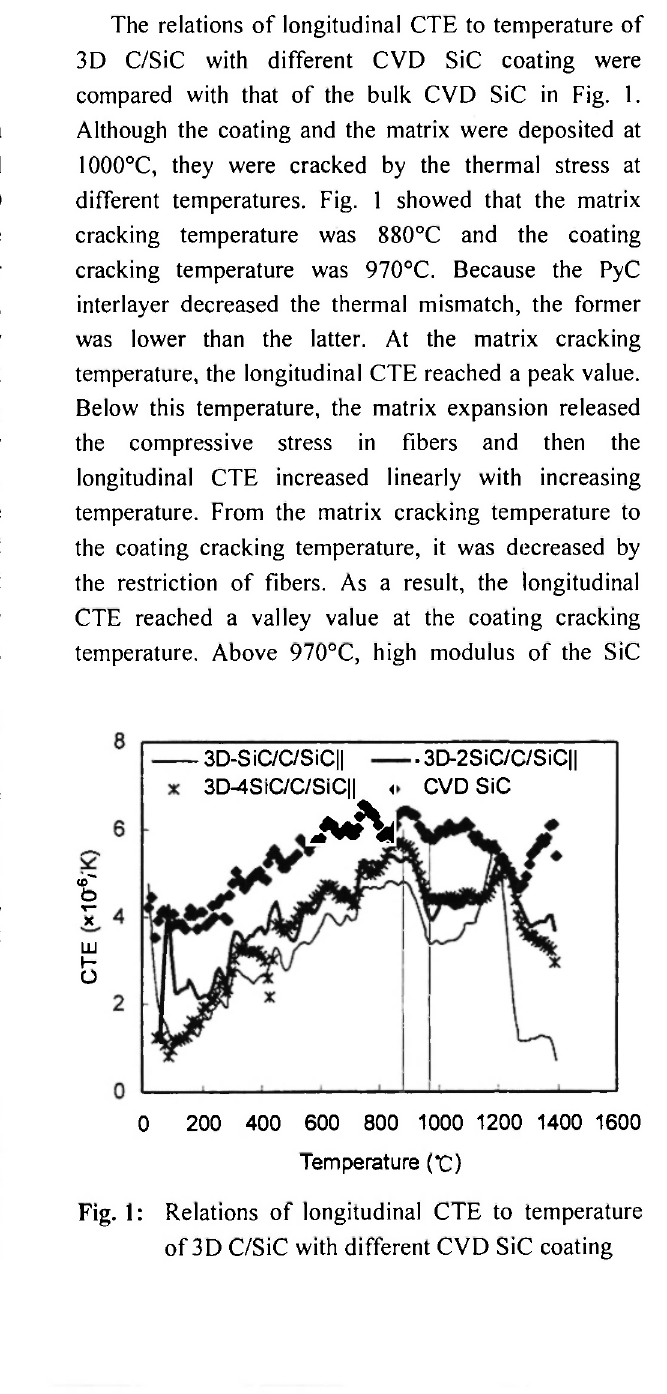
Fig. 1: Relations of longitudinal CTE to temperature of 3D C/SiC with different CVD SiC